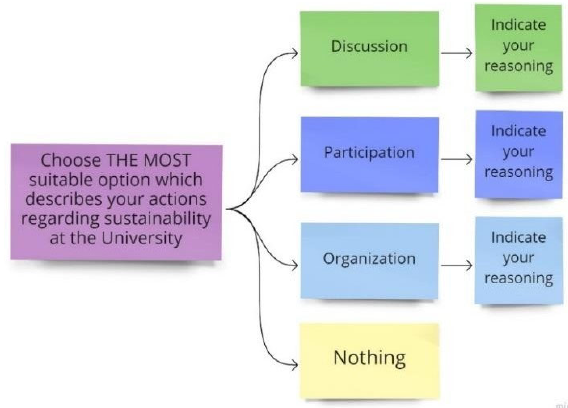
Figure 5. Skip-logic algorithm for questions of “active participation category”. Figure 5. Skip ‐ logic algorithm for questions of “active participation category”.